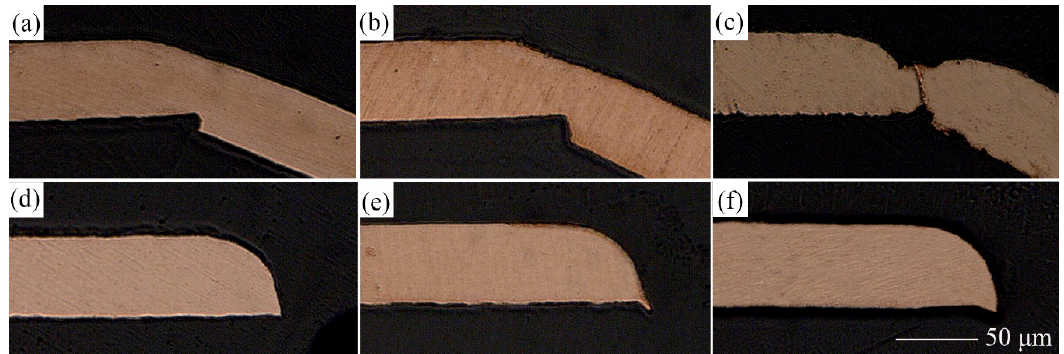
Figure 10. Section morphology of punched parts with LPS under different laser power densities. ( a )